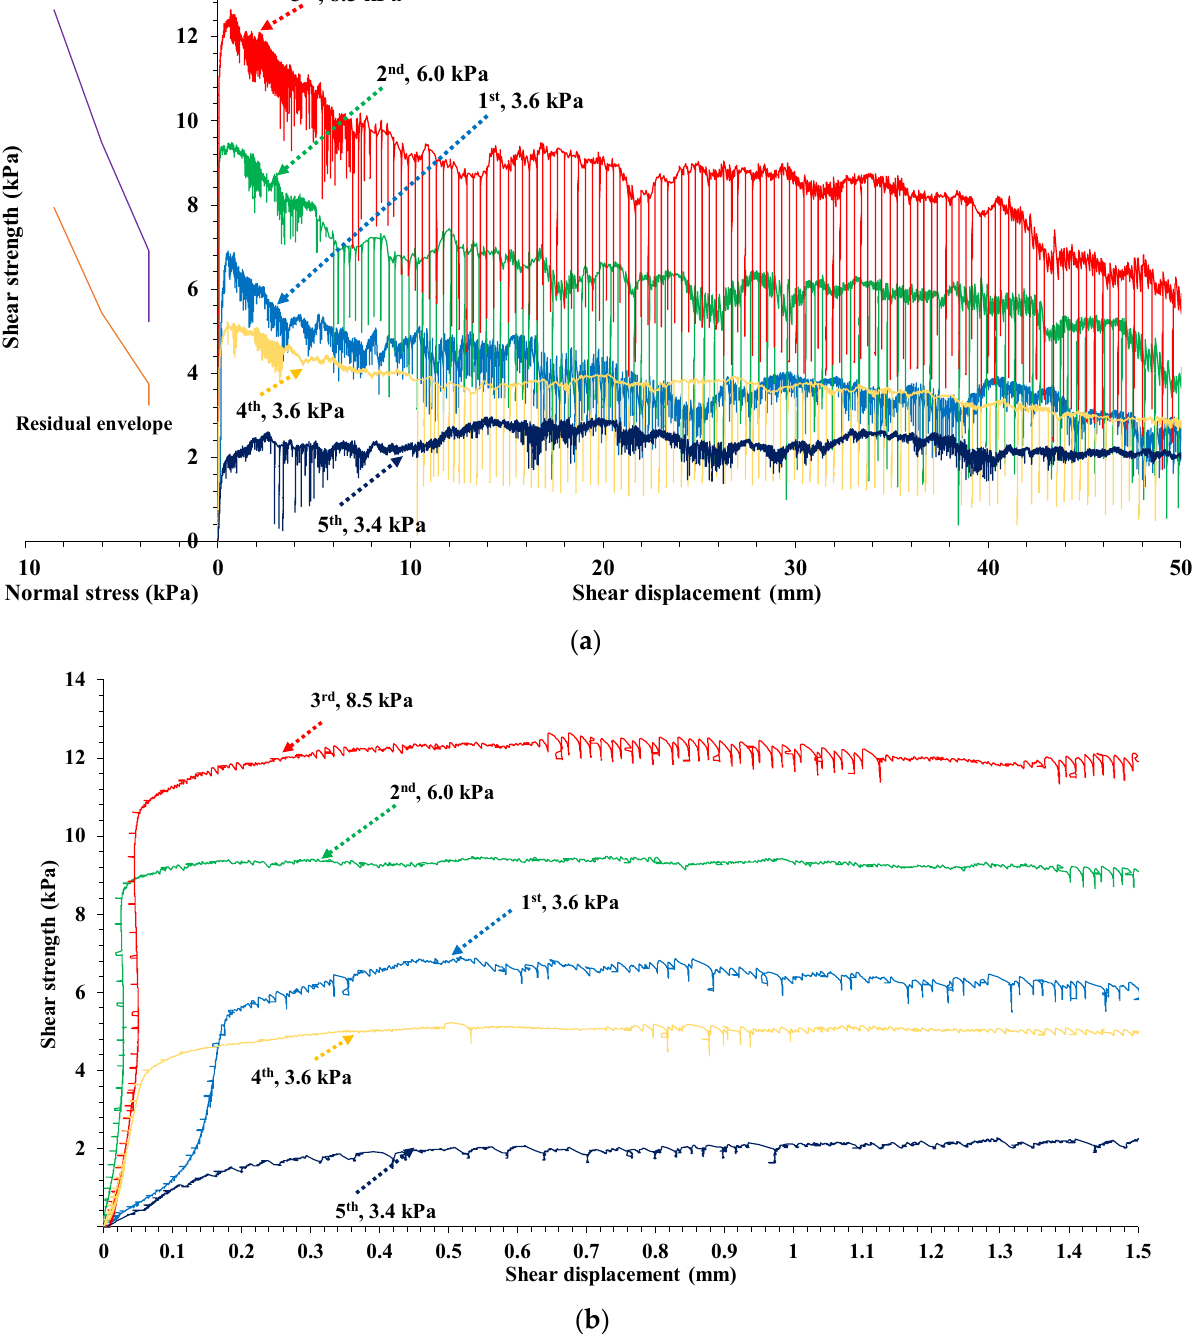
Figure 12. Shear test results for the large sample (2000 mm × 1000 mm) as a function of normal stress and shear displacement: ( a ) 50 mm displacement, ( b ) 1.5 mm displacement.